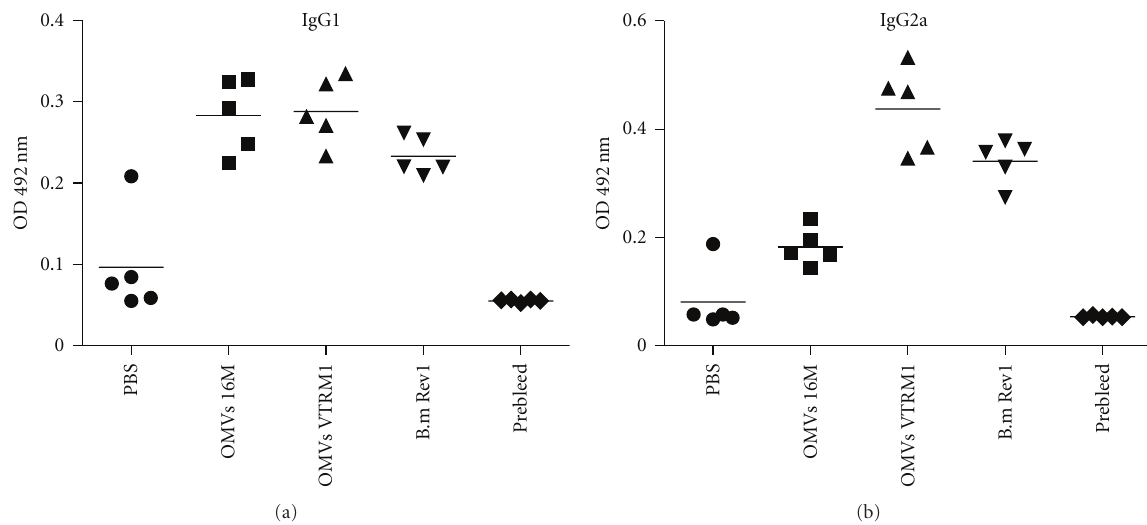
Figure 4: Level of protection against B. melitensis 16M conferred by outer membrane vesicles purified from B. melitensis 16M and B. melitensis VTRM1. In this experiment vaccine strain B. melitensis Rev1 was used as a positive control of vaccination, as negative control was used saline. n = 5 ( ∗ P ≤ 0 . 005 comparisons were OMVs versus saline, and B. melitensis Rev1 versus saline).